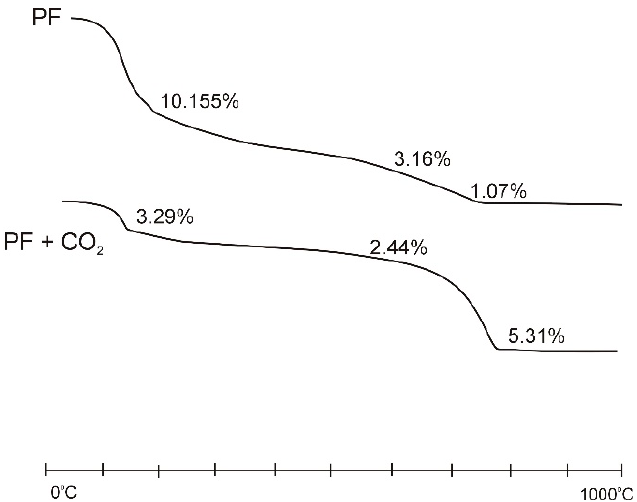
Figure 5. TG curves for suspensions of PF FBC fly ashes: clean (PF) and treated with CO 2 (PF with CO 2 ).